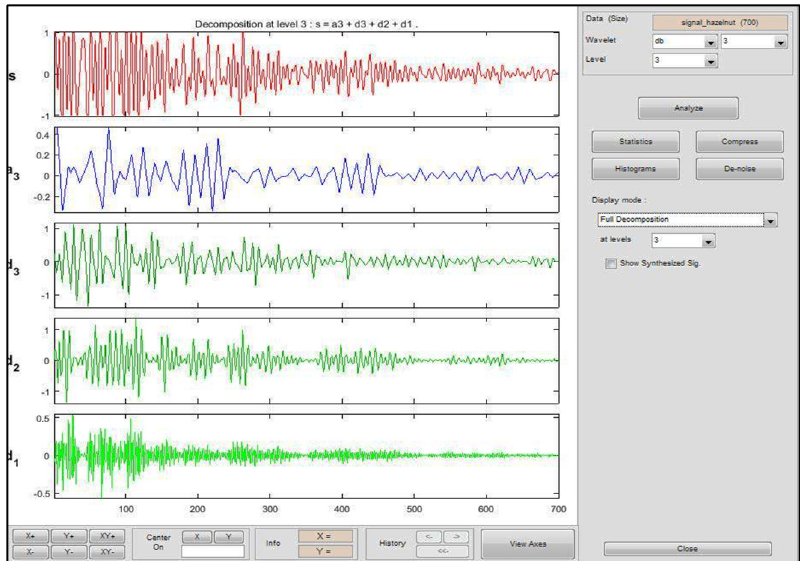
Figure 13. Representation of three ‐ step discrete wavelet transforms calculation using a filter bank idea